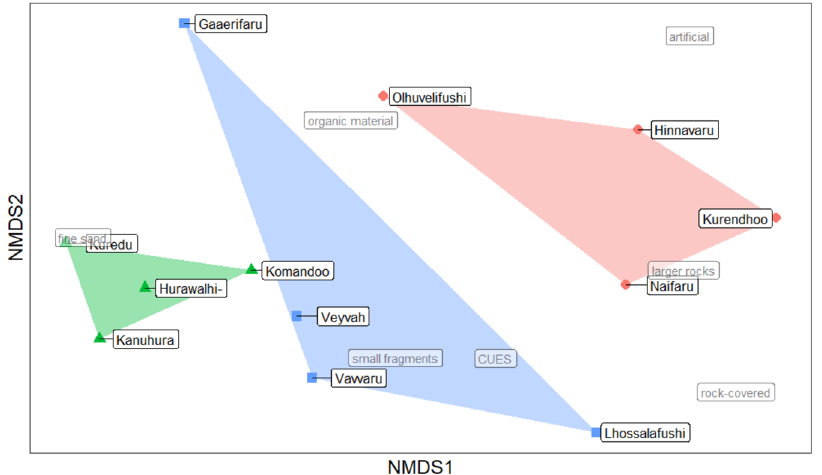
Figure 2. Distinctness of the three investigated island types. NMDS ordination of the investigated islands (blue squares and blue cluster area: uninhabited islands, red circles and red cluster area: local islands, green triangles and green cluster area: tourist islands) is based on the three resource and habitat parameters that influence hermit crab abundance and size (food, shell and habitat availability)). NMDS ordination thereby groups points, i.e. islands, with similar values closer together. Spatial proximity of a data point, i.e. an island, to one of the investigated parameters shows that the island is described by high values in the respective parameter.